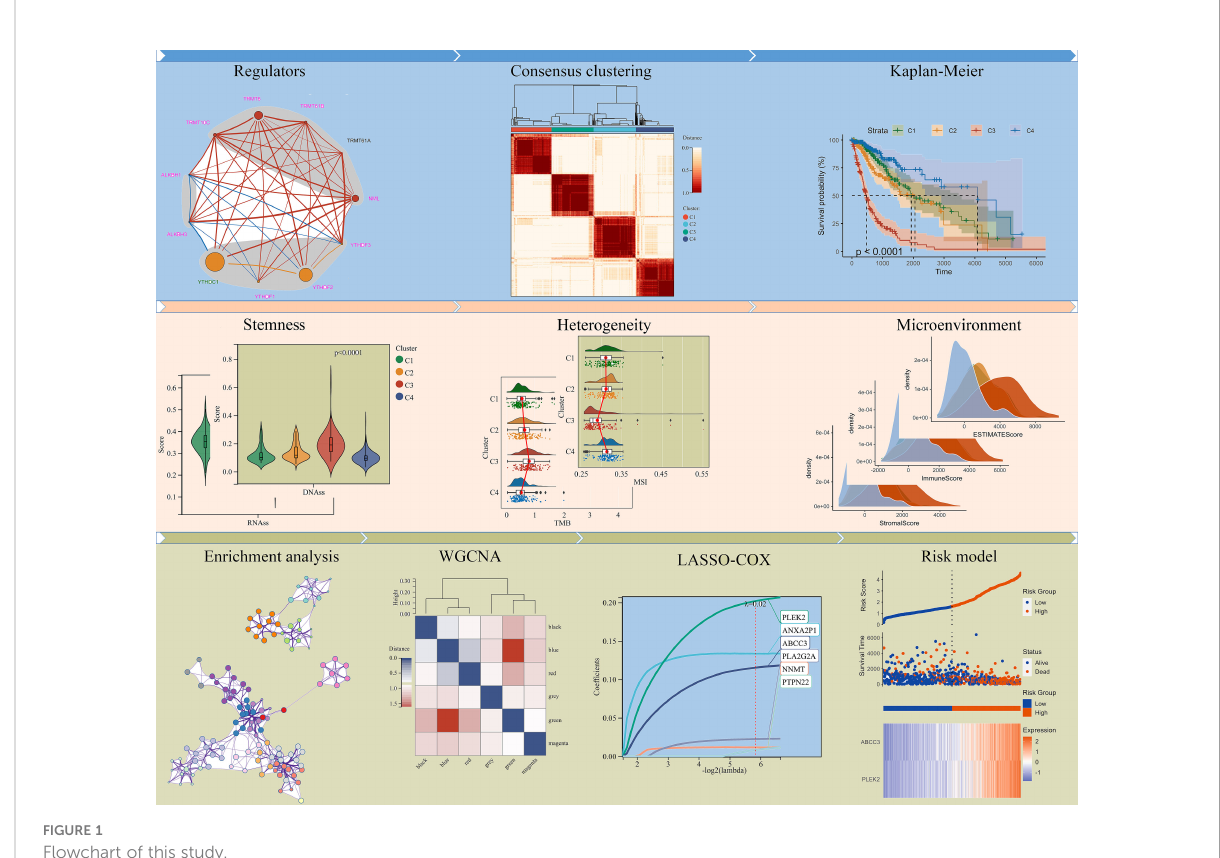
FIGURE 1 Flowchart of this